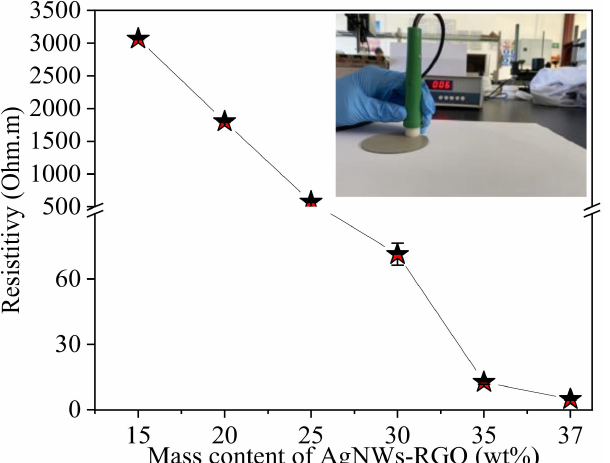
Figure 7. Resistivities of the composite films with different AgNWs-RGO mass contents. The inset is a photograph of the testing